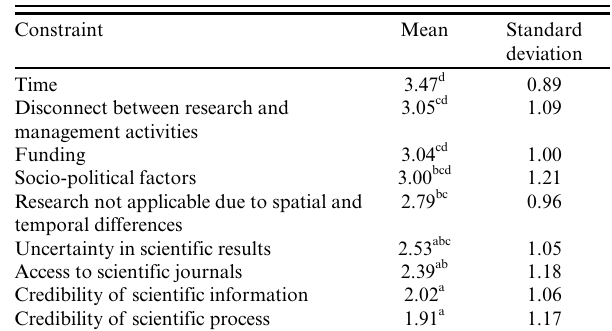
Table 3 . Mean value and standard deviation from 57 survey respondents for how limiting (1 = not limiting, 4 = very limiting) different constraints are when incorporating new scientific information into the decision-making process. An analysis of variance and Tukey’s HSD test was performed on each dataset to determine statistical differences in mean rank between metrics. Superscript letters that differ indicate ranks that differ at alpha =